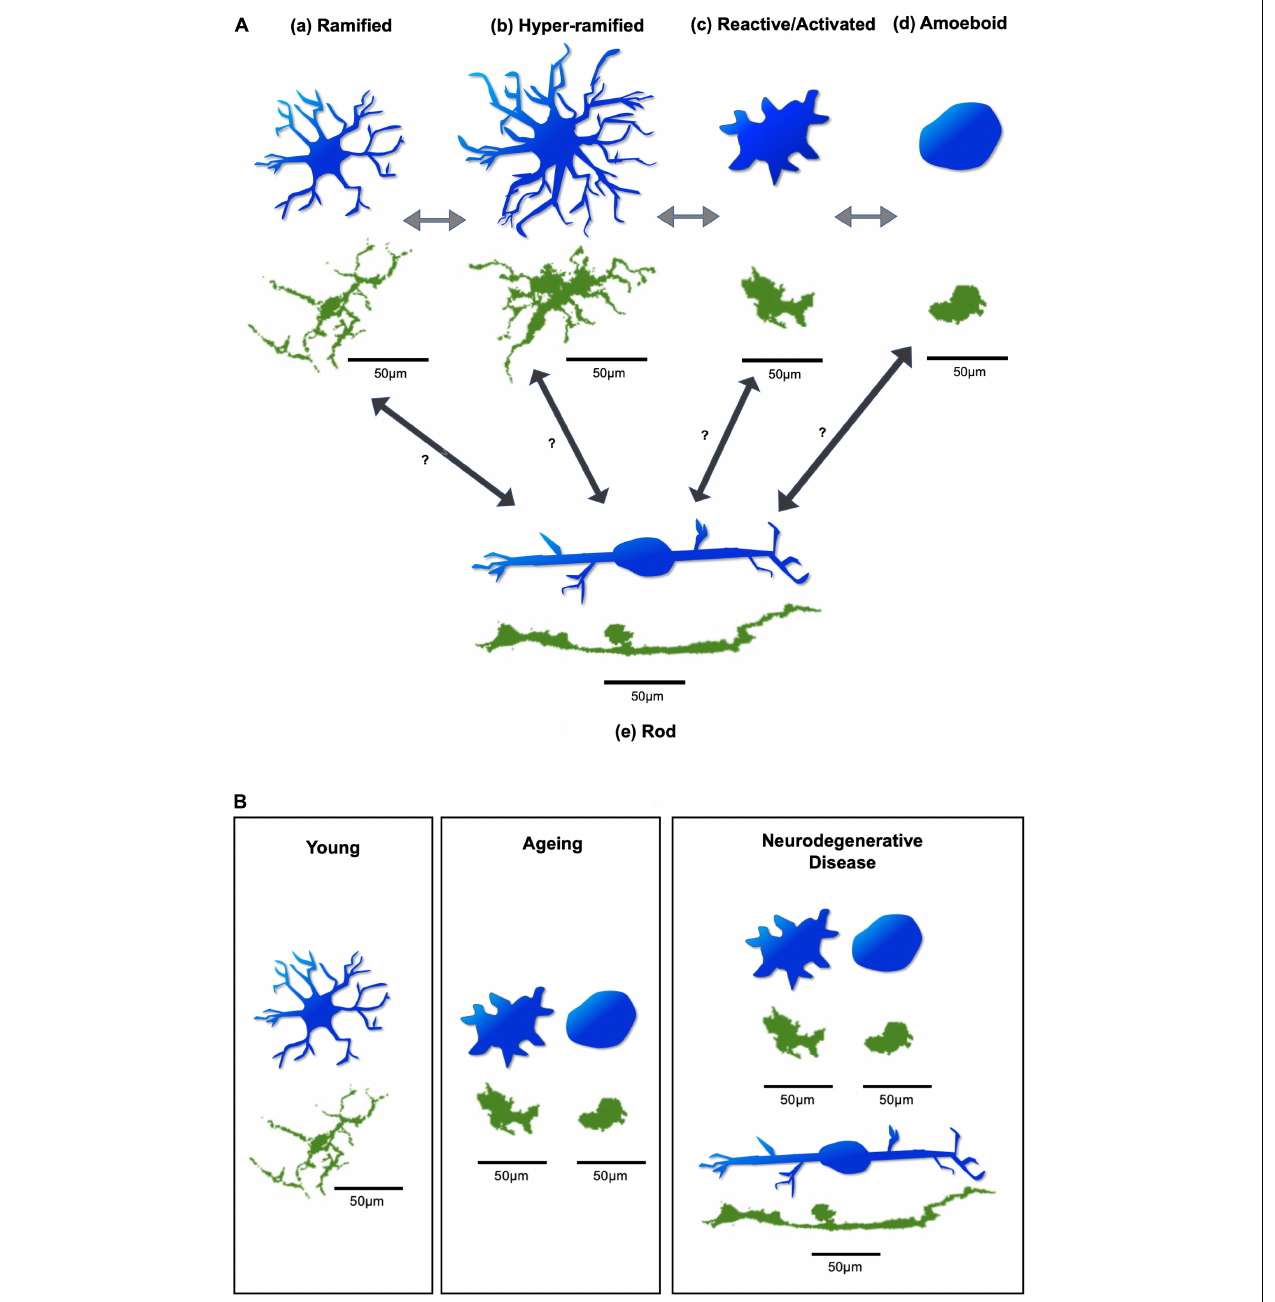
FIGURE 2 | Diagram of microglial morphologies. (A) Microglial morphology varies based on activation state, in response to changing environmental conditions. Arrows demonstrate possible transitions between states. These transitions can occur in both directions, allowing microglia to switch back and forth between activation states. (a) Microglia under resting physiological conditions have a ramified appearance. (b) Disruption to environmental homeostasis leads them to elongate their processes and transiently exhibit a hyper-ramified state. (c) In response to considerable environmental damage, they rapidly adopt an activated morphology, with an increased soma size, and thicker, shorter processes. (d) Substantial insult leads them to adopt an amoeboid appearance, with complete retraction of processes, allowing directed motility and phagocytosis of target material. (e) Rod microglia, which are specifically associated with retinal neurodegeneration, exhibit a uniquely narrow and elongated morphology, with few processes. It is unclear which microglial activation state(s) give(s) rise to rod microglia. Figure based on Holloway (Holloway et al., 2019). (B) Different predominant morphologies and activation states of microglia may be found in the young, ageing, and neurodegenerative retina. Generally, ramified microglia may be predominantly found in the young retina. In the ageing retina, the reactive/activated and amoeboid microglia are predominantly found. In cases of retinal neurodegenerative disease, reactive/activated, amoeboid, and rod microglia are predominantly found. Blue microglia are illustrative representations to demonstrate morphological changes. Green microglia are from whole-mount retinal images of Iba-1 stained C57BL6 mice, obtained from the Cordeiro laboratory. Scale bar = 50 µ m.